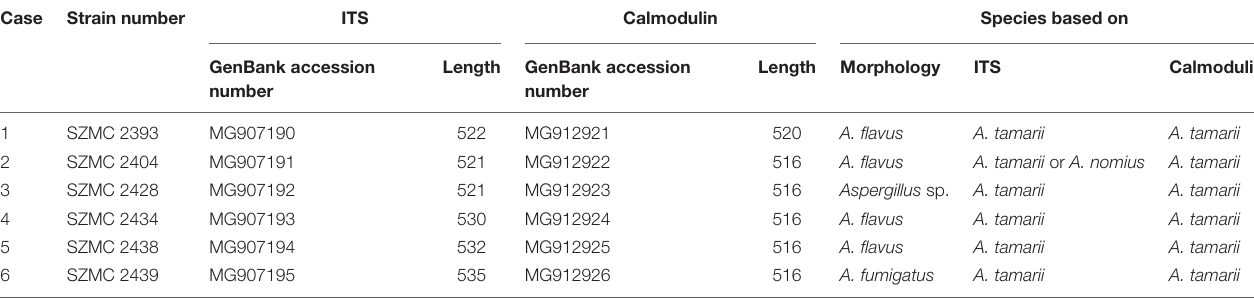
TABLE 1 | Results of the identification of Aspergillus spp. from